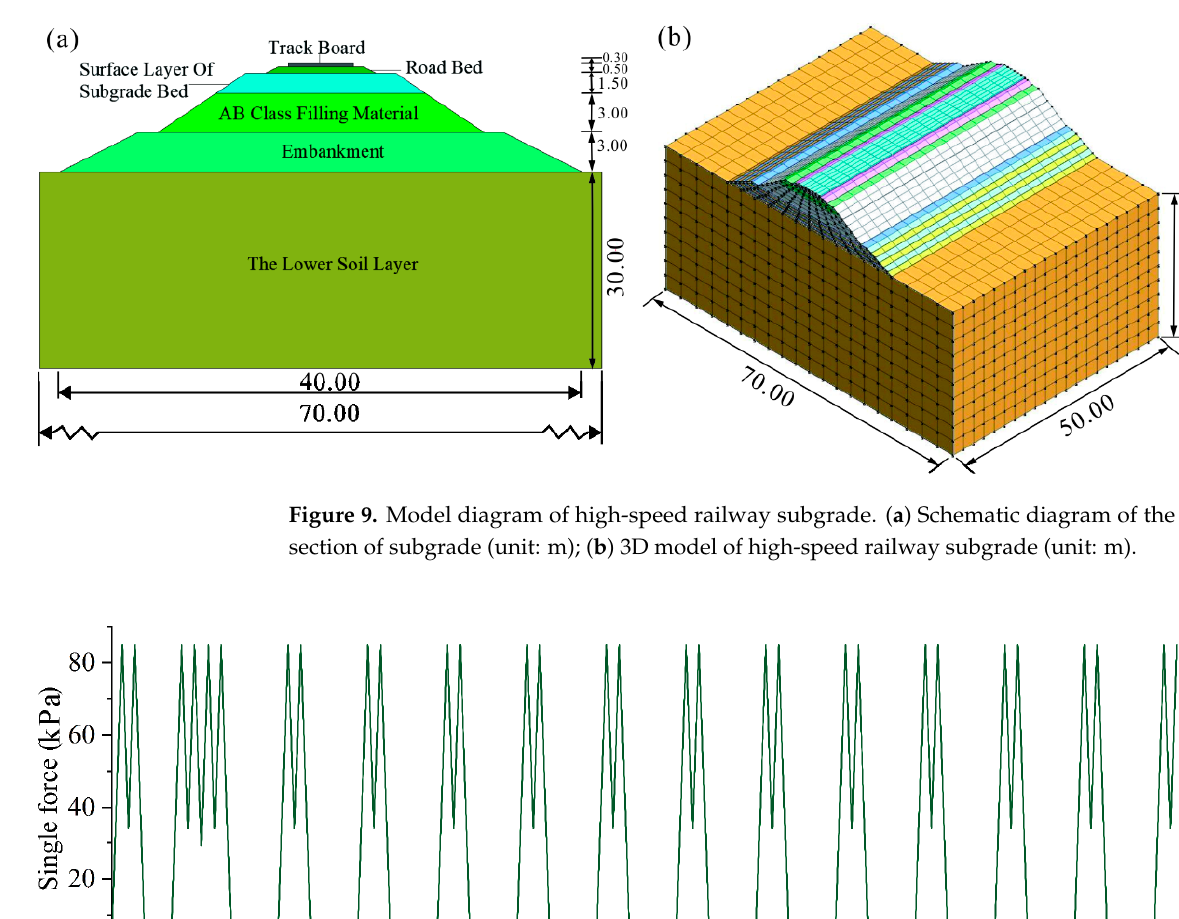
Table 8. Calculation parameters of the finite element model.